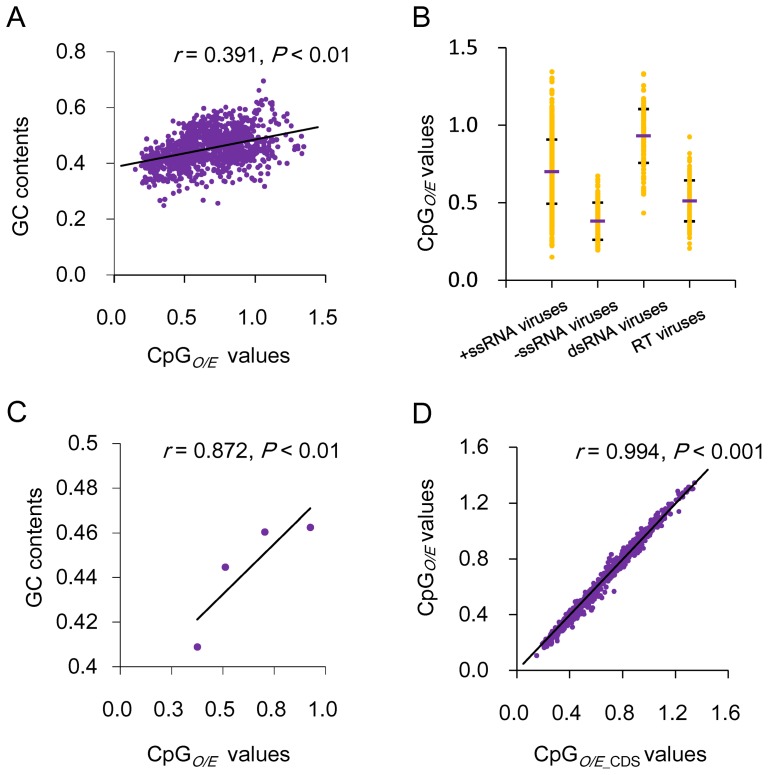
The influence of GC content on viral CpG usage.(A) Correlation between CpG odds ratios and GC contents of RNA viruses. (B) CpG usage variation between the four groups of RNA viruses. CpGO/E distribution range of each viral group is shown by yellow dots, and the mean CpGO/E value of each viral group is indicated by the purple bar. The standard deviations of the mean CpGO/E values are also indicated. (C) Correlation between the mean CpGO/E and mean GC content values. (D) Correlation between the CpGO/E and CpGO/E
_CDS values.